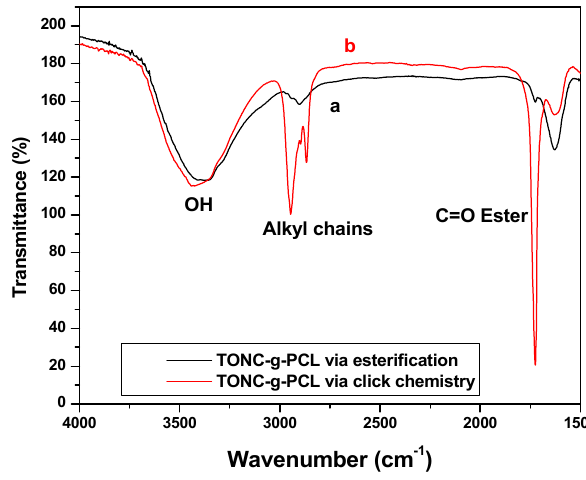
Figure 4. FTIR spectra of PCL ( a ) and azido-polycaprolactone (PCL-N3) ( b